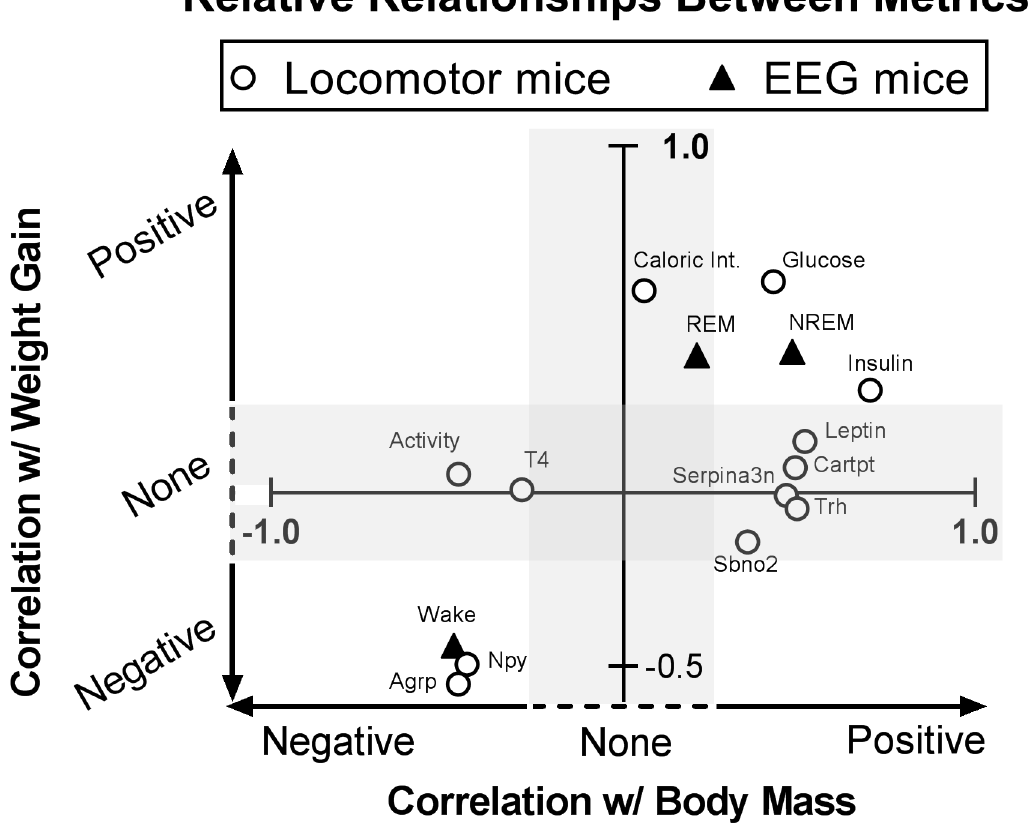
Fig 5. Plotting standardized correlation coefficients to visualize how blood biomarkers, VH gene expression, and behavioral data relate. For each output metric, standardized β coefficients (Std β xy ) were calculated for both weight metrics (body weight and Δ body weight) and plotted together here. Any values to the right of the y-axis are positively associated with increased body weight, while any values to the left of the y-axis decrease as body mass increases. Any values above the x-axis increase as Δ body weight increases (positive energy balance), while points below the x-axis decrease as Δ body weight increases. Points in the shaded area represent non-significant associations. Exact Std β xy and p-values are shown in Table 3. REM: Rapid eye movement sleep; NREM: Non-REM sleep; cartpt : cocaine- and amphetamine regulated transcript; serpina3n :serine (or cysteine) peptidase inhibitor clade A member 3N; sbno2 : strawberry notch homolog 2; trh : thyrotropin-releasing hormone; agrp :agouti-related peptide; npy : neuropeptide y; T4: